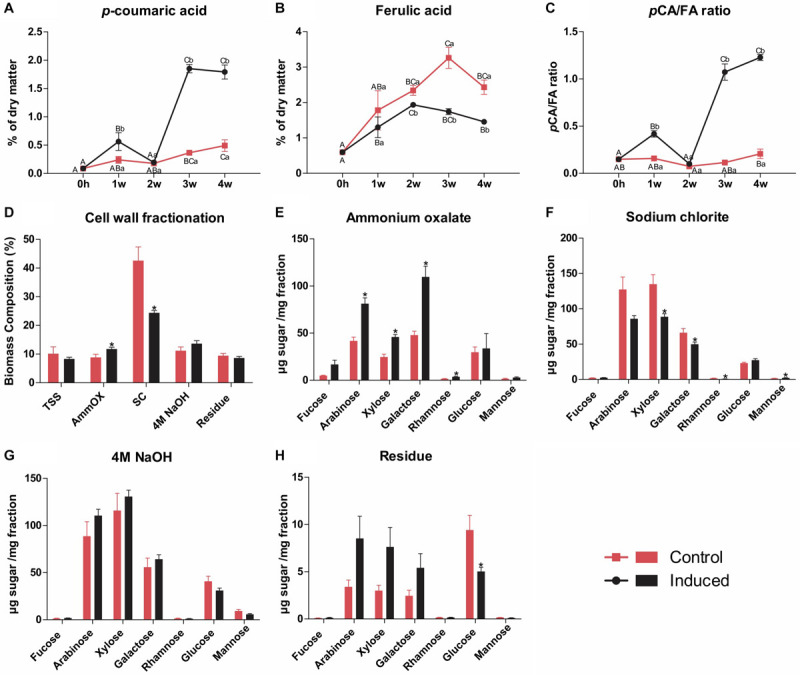
Wall-bound hydroxycinnamates quantification and cell wall fractionation of residues isolated from control and induced sugarcane suspension cells. Hydroxycinnamates were quantified by HPLC after alkaline hydrolysis from samples harvested weekly along a time frame of 4 weeks. Cell wall fractionation was performed in samples from control and induced cells after 4 weeks of treatment. (A)
p-coumarate content determined by HPLC after alkaline hydrolysis. Data are expressed as percentage of dry matter. Error bars represent SE (n = 4). (B) Ferulate content determined by HPLC after alkaline hydrolysis. Data are expressed as percentage of dry matter. Error bars represent SE (n = 4). (C) Ratio of p-coumarate to ferulate. Data are means ± SE (n = 4). (D) Yields of total soluble sugars and polysaccharides sequentially extracted upon cell wall fractionation from control and induced cells. Data are expressed as percentage of total biomass ± SE (n = 5). (E) Monosaccharide composition of the ammonium oxalate extract. Data are means ± SE (n = 5). (F) Monosaccharide composition of the sodium chlorite extract. Data are means ± SE (n = 5). (G) Monosaccharide composition of the 4M NaOH extract. Data are means ± SE (n = 5). (H) Monosaccharide composition of the insoluble wall residue. Data are means ± SE (n = 5). For the hydroxycinnamates data, statistical differences were assessed using one-way ANOVA and Tukey’s post hoc test (P < 0.05) for comparisons along time in the same treatment and using Student’s t-test (P < 0.05) between control and induced samples at each time point. Different uppercase letters represent significant differences along the time series, whereas different lowercase letters represent significant differences between treatments. For the cell wall fractionation data, statistical differences (indicated by asterisks) were assessed between control and induced samples using Student’s t-test (P < 0.05).